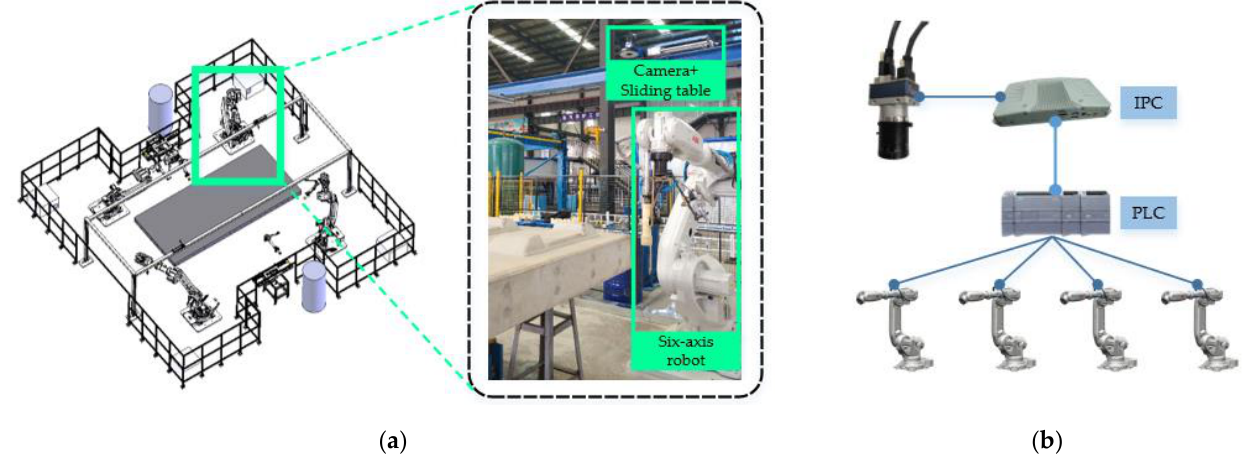
Figure 15. ( a ) Device distribution model. ( b ) Diagram of device connection.